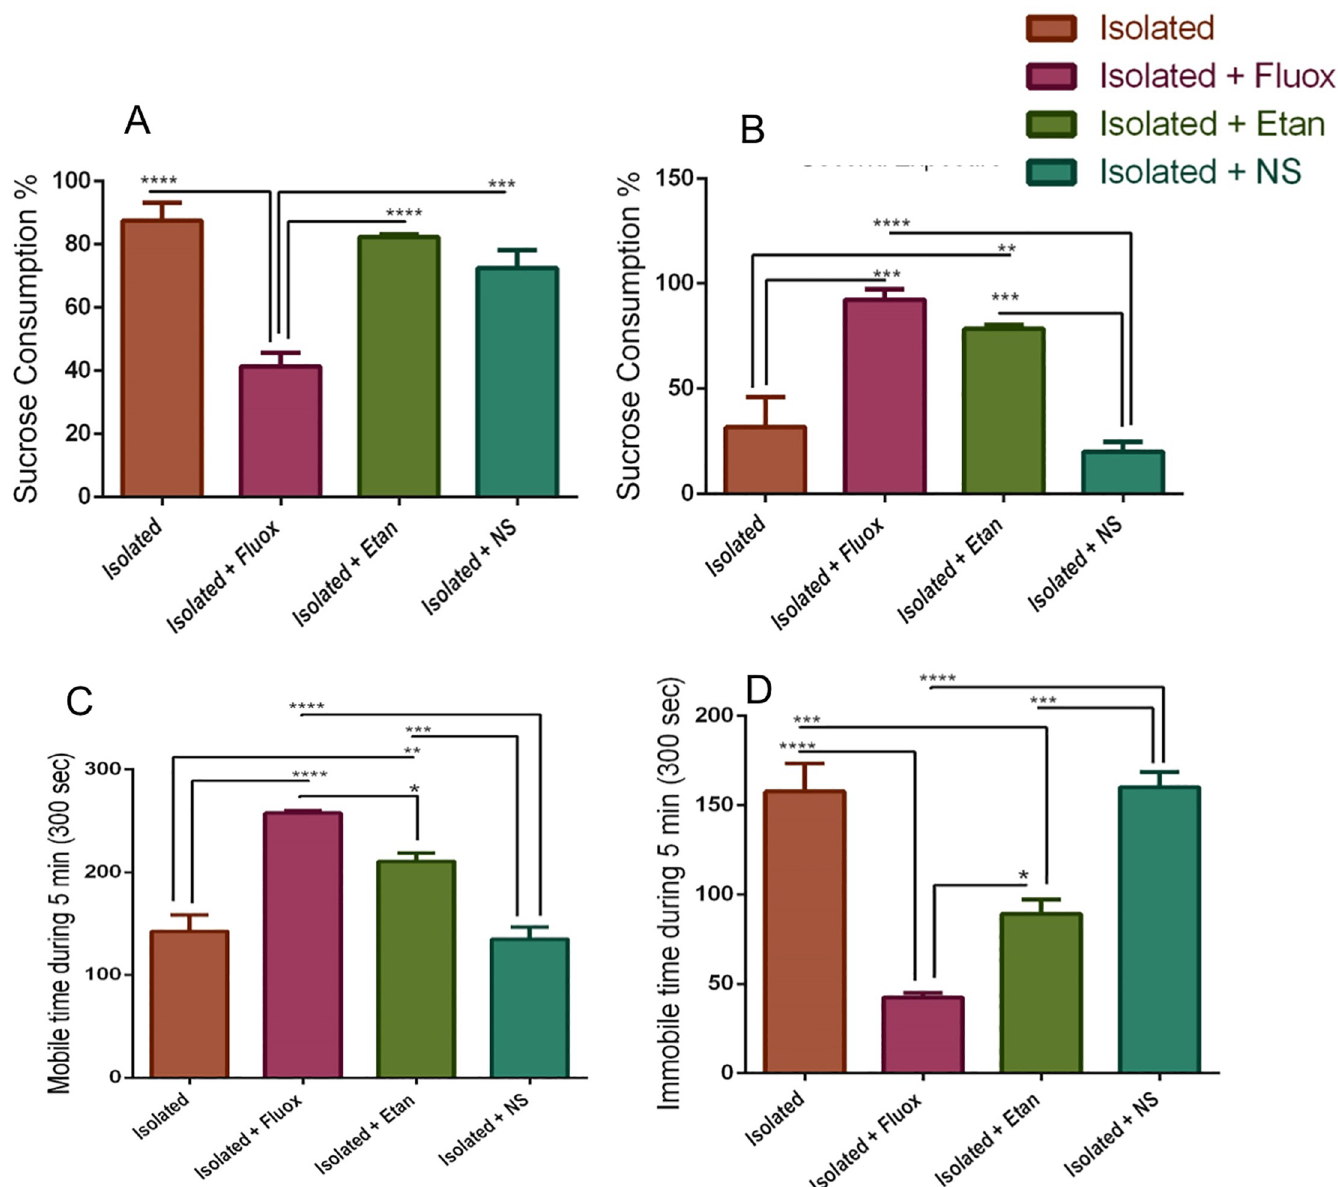
Fig 4. The Effect of pharmacological intervention in SPT and FST. Rats were initially exposed to the sucrose to assess the neophobia (A) First-day exposure. On the second day rats were exposed to the sucrose to test depressive-like behavior, (B) Second exposure. The presence or absence of mobility or immobility behavior were registered every 5s (bins) in the second session of FST, n = 6 per group. (C) Showed the significant of mobility between fluoxetine treatment and etanercept to the isolation, (D) shows the significant of immobility between isolation to fluoxetine treatment and etanercept. Results represent the mean ± SEM. Data were analyzed using one-way ANOVA followed by Tukey’s test. � P < 0.05, �� P < 0.01, ��� P <